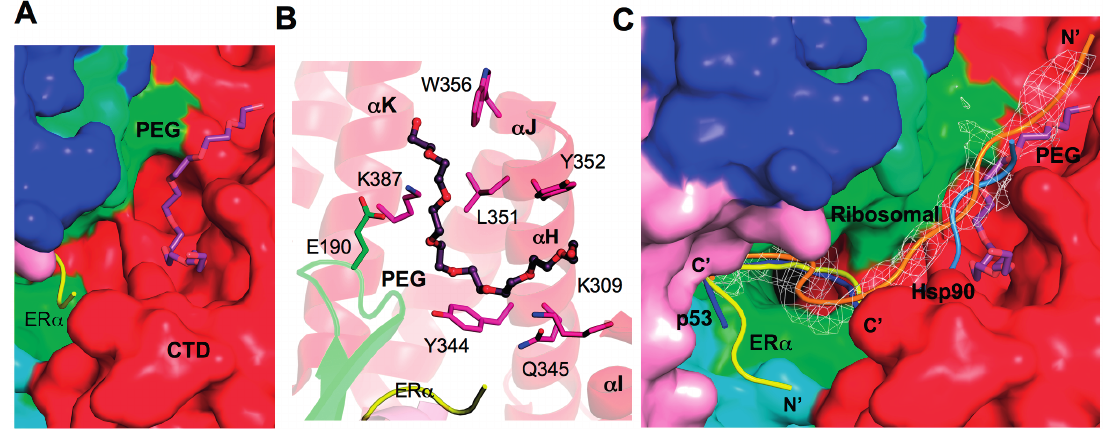
Figure 7. Additional substrate binding site. ( A ) Surface representation of the PEG binding site in SMYD2. PEG is depicted by sticks with the carbon atoms colored in purple. ER α peptide is displayed as ribbon and colored yellow; ( B ) Putative PEG interacting residues. SMYD2 residues are colored according to domains. ER α residues are shown in yellow. PEG is represented in the same way as in ( A ); and ( C ) Comparison of the binding sites of ER α (yellow), p53 (blue), PEG (purple), Hsp90 (light blue), and a ribosomal peptide (orange). The ribosomal peptide is overlaid with 2 F o − F c omit map calculated at 2.8 Å and contoured at 1.5 σ . The Hsp90 peptide is modeled by superposition of the SMYD2 CTD and Hop1